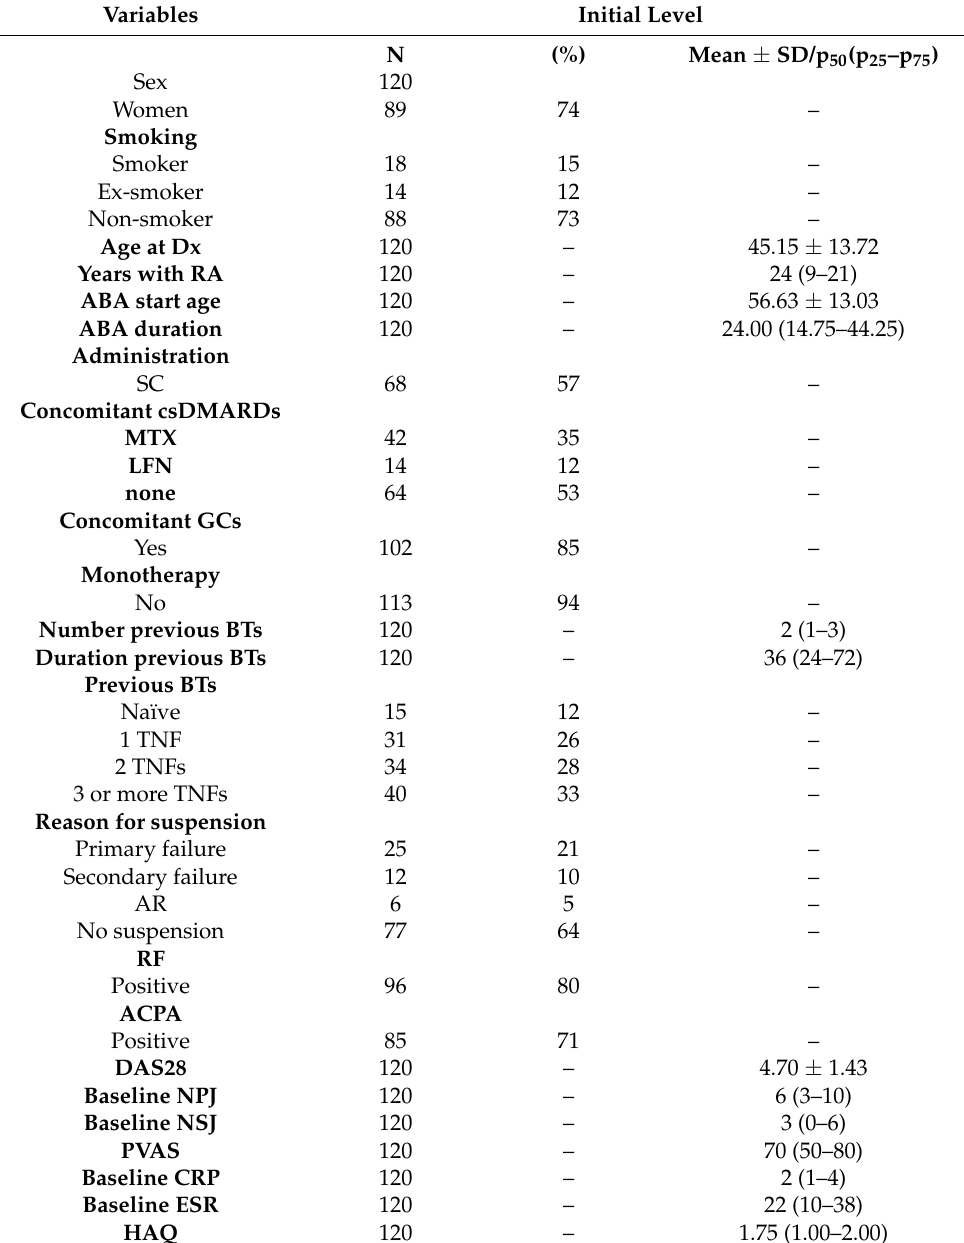
Table 1. Clinical and demographic features of RA patients treated with